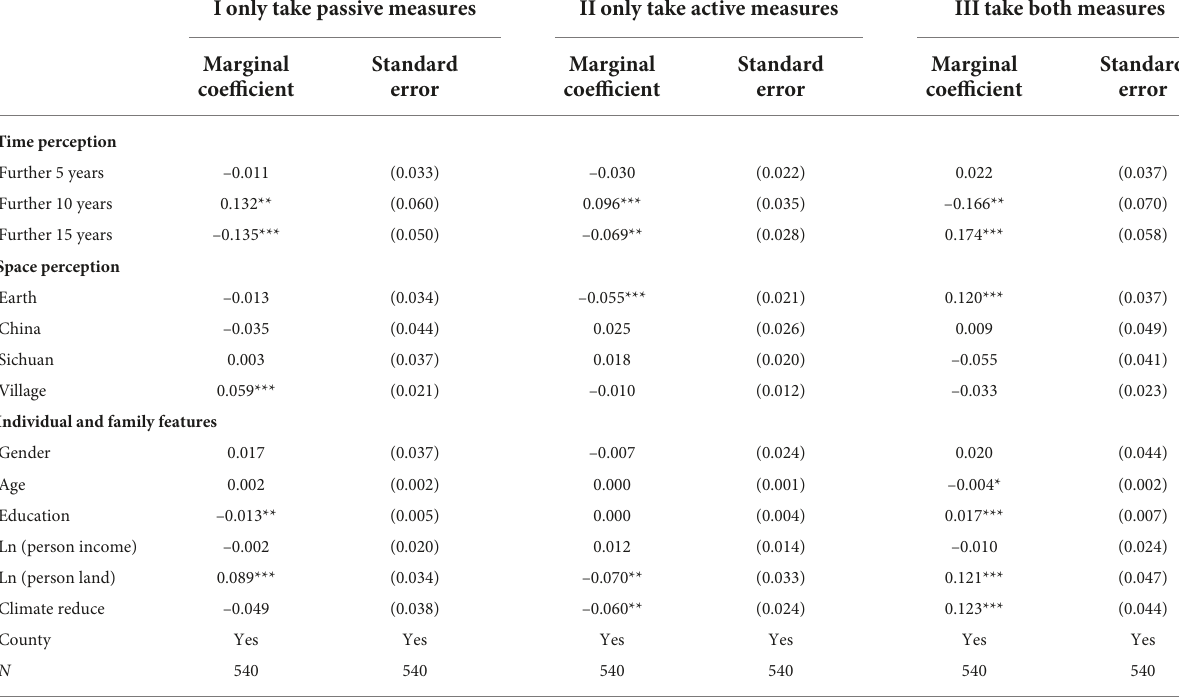
TABLE 4 Impacts of time-space perception of climate change on farmers’ adaptive behavior selection.